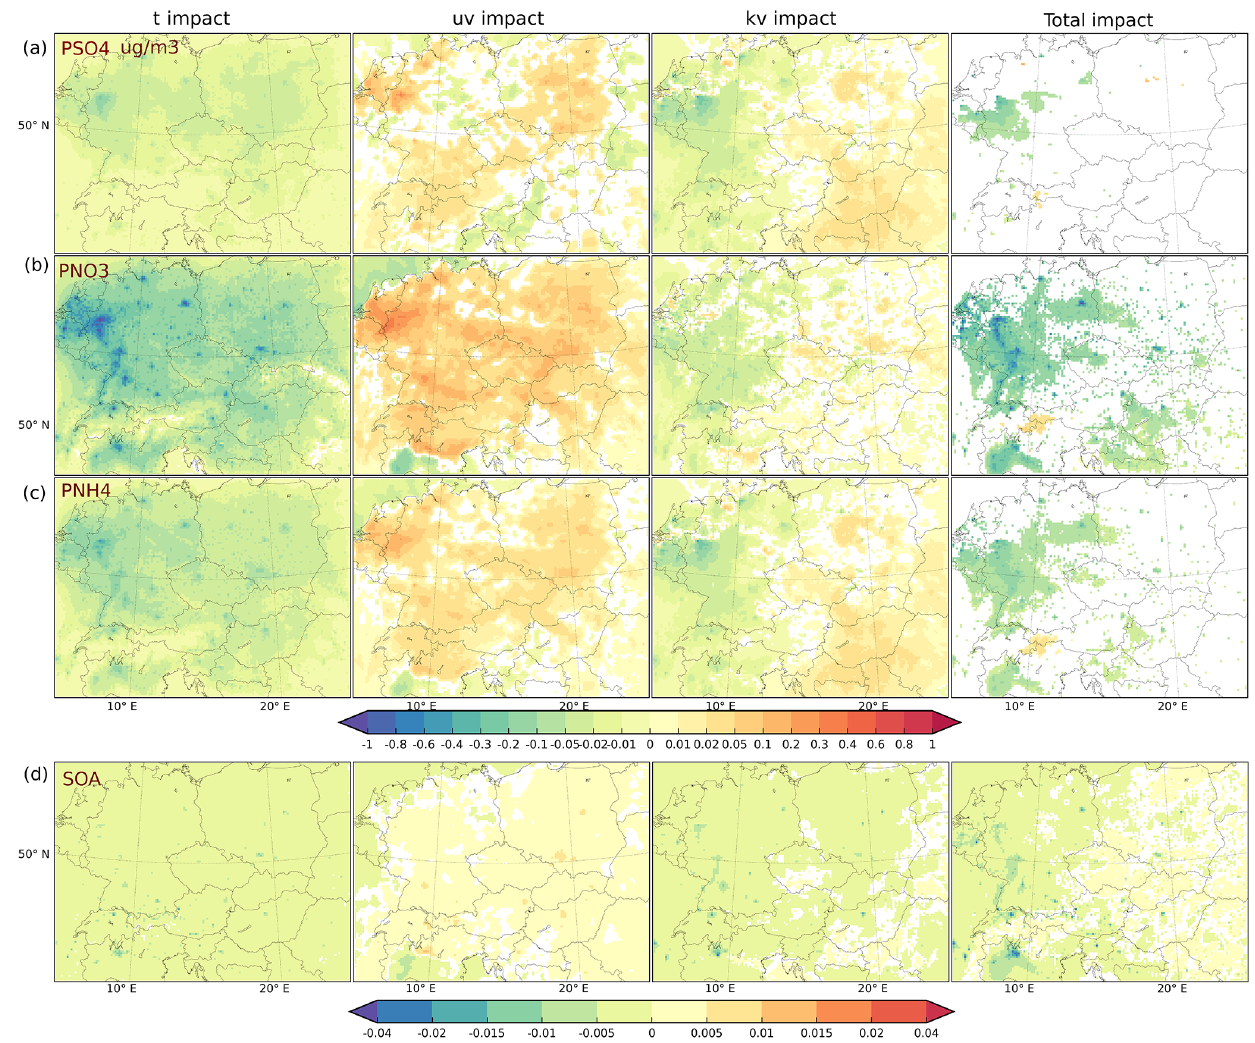
Figure 9. Impact of urban canopy meteorological forcing on (a–d) PSO 4 , PNO 3 , PNH 4 and SOA average 2001–2005 JJA surface concen- trations in µgm − 3 . The columns from left to right correspond to temperature, wind, turbulence and the total impact. Shaded areas represent a statistically significant impact at the 98% level using the t